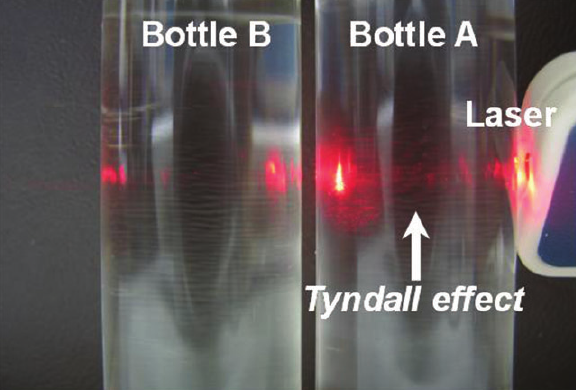
Figure 1 The pictures of the ethanol-in-PAO nanoemulsion fluids (Bottle A) and pure PAO (Bottle B). The liquids in both the bottles are transparent. The Tyndall effect (i.e., a light beam can be seen when viewed from the side) can be observed only in Bottle A when a laser beam is passed through Bottles A and B.